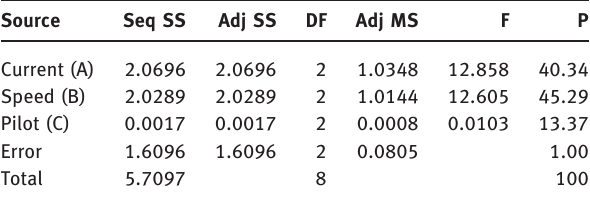
Table 6: ANOVA analysis.